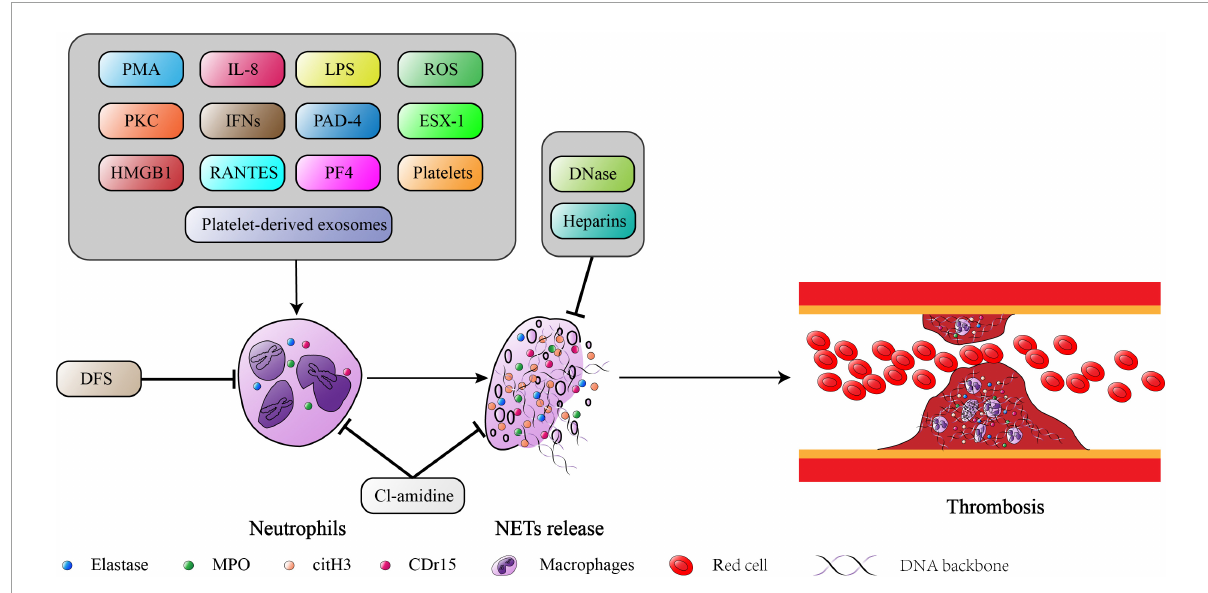
FIGURE2 The summarized mechanism of NETs formation and its consequences in thrombosis. The figure was constructed by Adobe